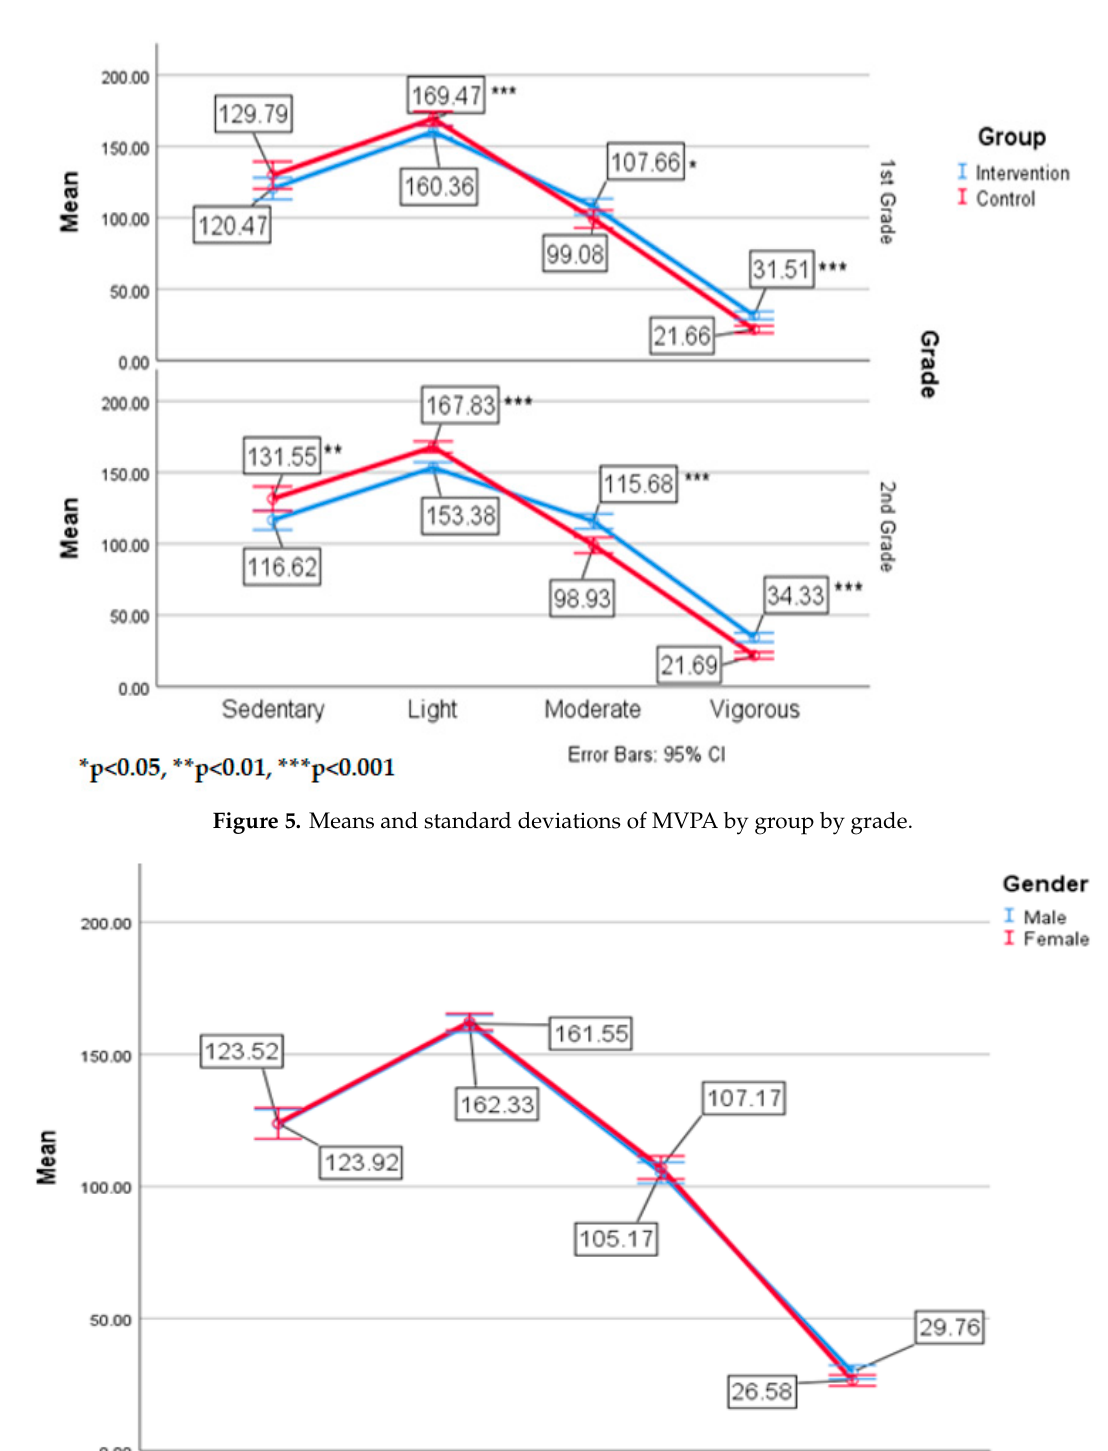
Figure 6. Means and standard deviations of MVPA by gender .